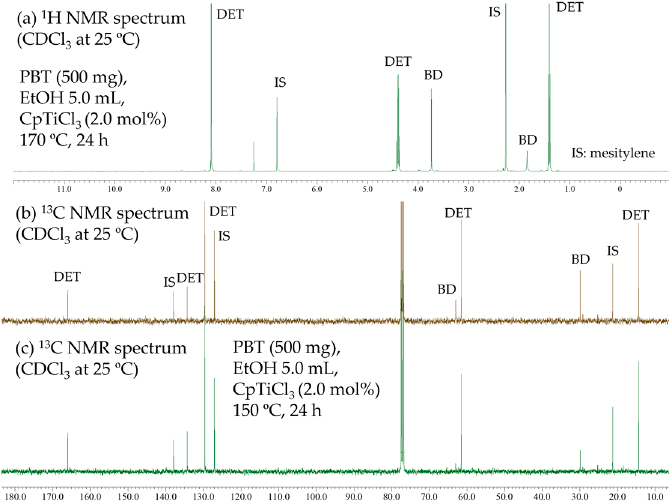
Figure 7. NMR spectra (in CDCl 3 at 25 °C) for transesterification of PBT with ethanol by CpTiCl 3 (2.0 mol%). Conditions: PBT 500 mg, ethanol 5.0 mL, ( a , b ) 170 °C, 24 h; ( c ) 150 °C, 24 h. (2.0 mol%). Conditions: PBT 500 mg, ethanol 5.0 mL, ( a , b ) 170 ◦ C, 24 h; ( c ) 150 ◦ C, 24